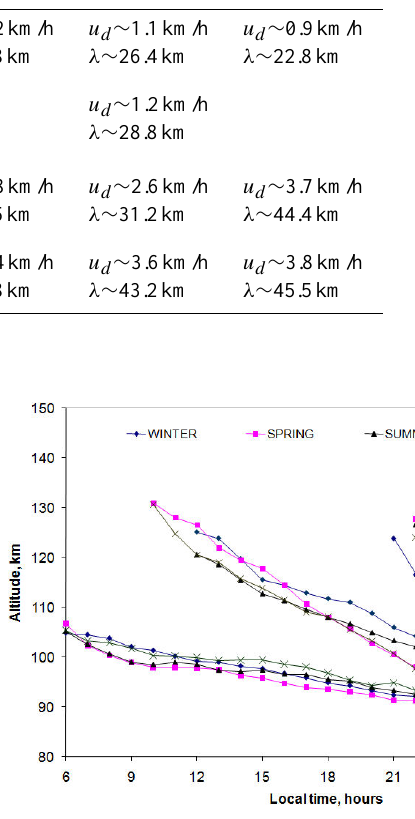
Table 1. Estimates of downward propagating phase speeds and wavelengths for the tides in relation with the observed averaged E s traces shown in Figs. 4 to 7 for all seasons. Winter Spring Summer Fall Dominant diurnal trace